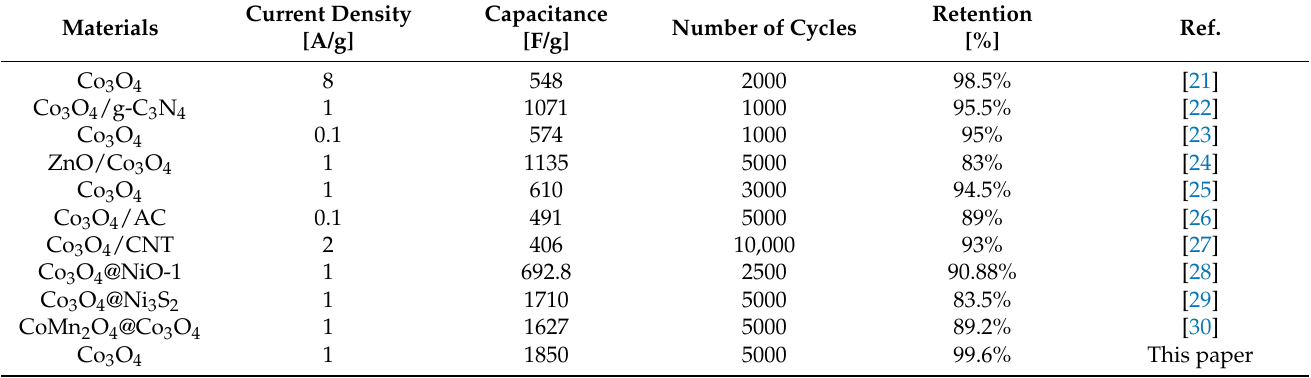
Table 1. The capacitance properties of the synthetic materials in this experiment are compared with those of the